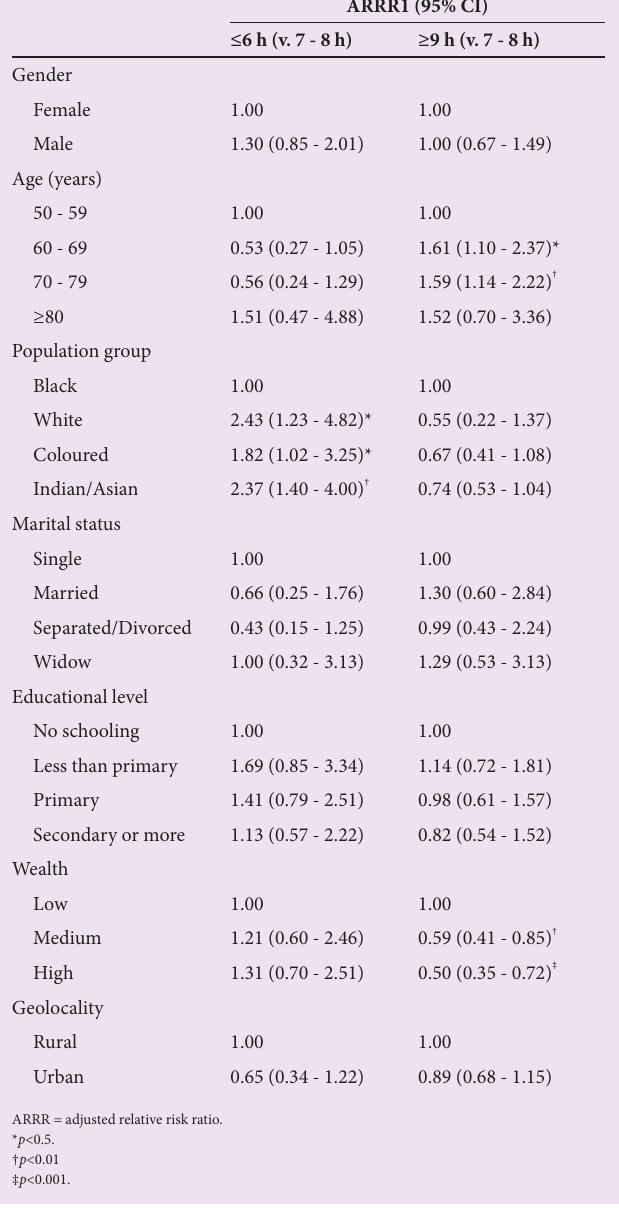
Table 4. Multinomial logistic regression: Sleeping duration and health variables in older South Africans